Question: Sum up the contents of this chart in one sentence.
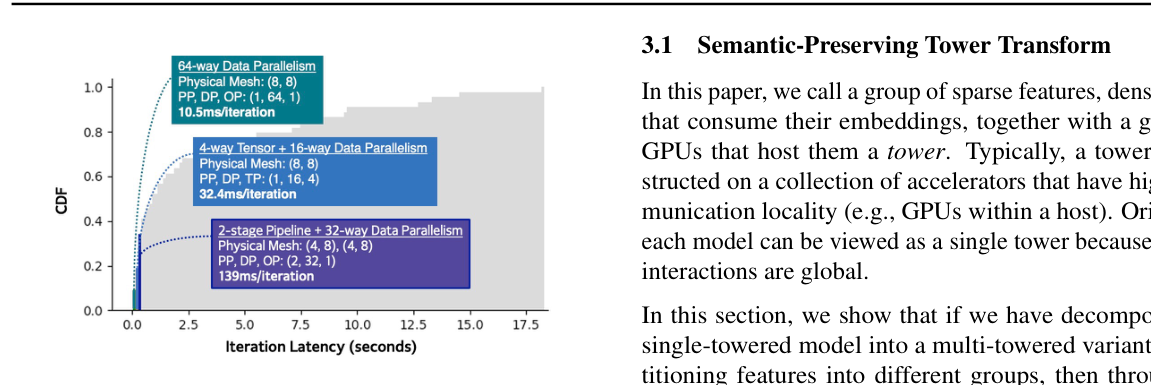
Answer: CDF of the iteration latency for various parallelism con- figurations running DLRM with Alpa.